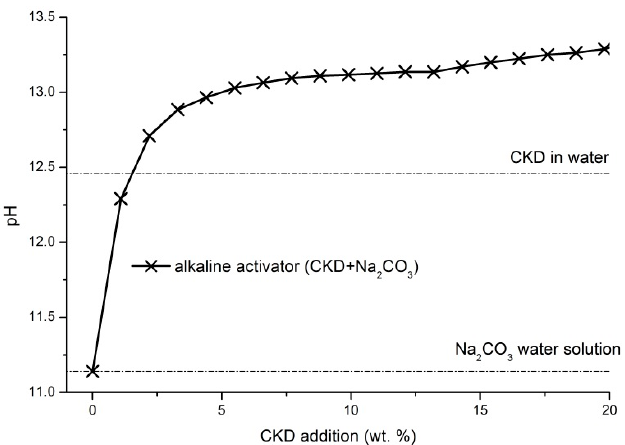
Figure 4. Effect of different amounts of CKD additions on the pH of water solution with dissolved sodium carbonate.